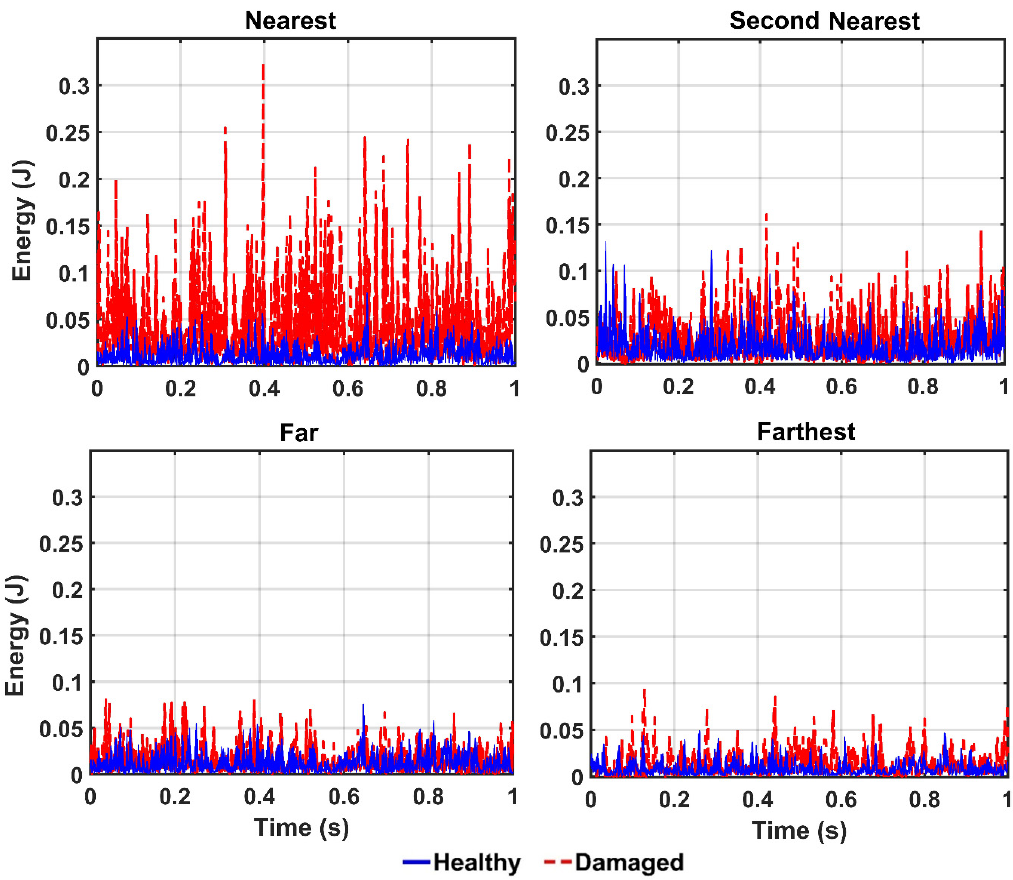
Figure 13. The energy output of the IMFs for different sensor locations from the damaged element by the proposed model.